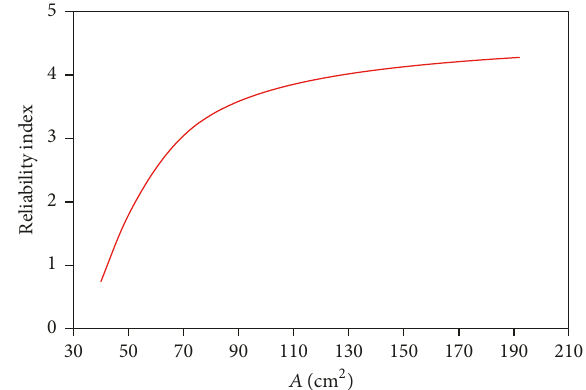
Figure 9: Reliability index with respect to the area of cross section of column